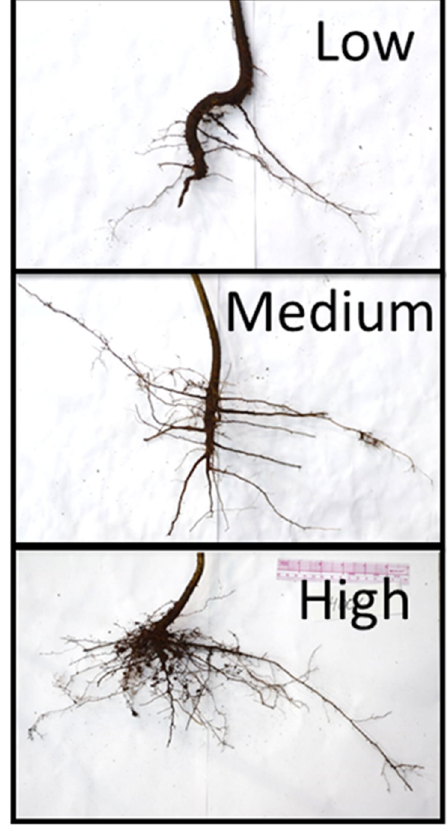
Figure 1. Example root mass classes. These root photographs are typical of American beech ( Fagus grandifolia ) wildling excavated seedlings. Table 1. The survival of purchased and wildling seedlings across root mass classes. Root mass class distinctions were used to divide American beech ( Fagus grandifolia ) seedlings into three qualitative